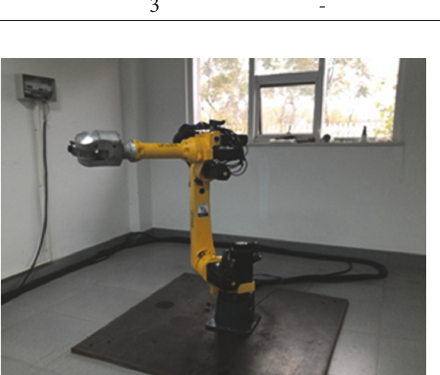
Figure 2: ER-16 6-DOF robot manipulator.